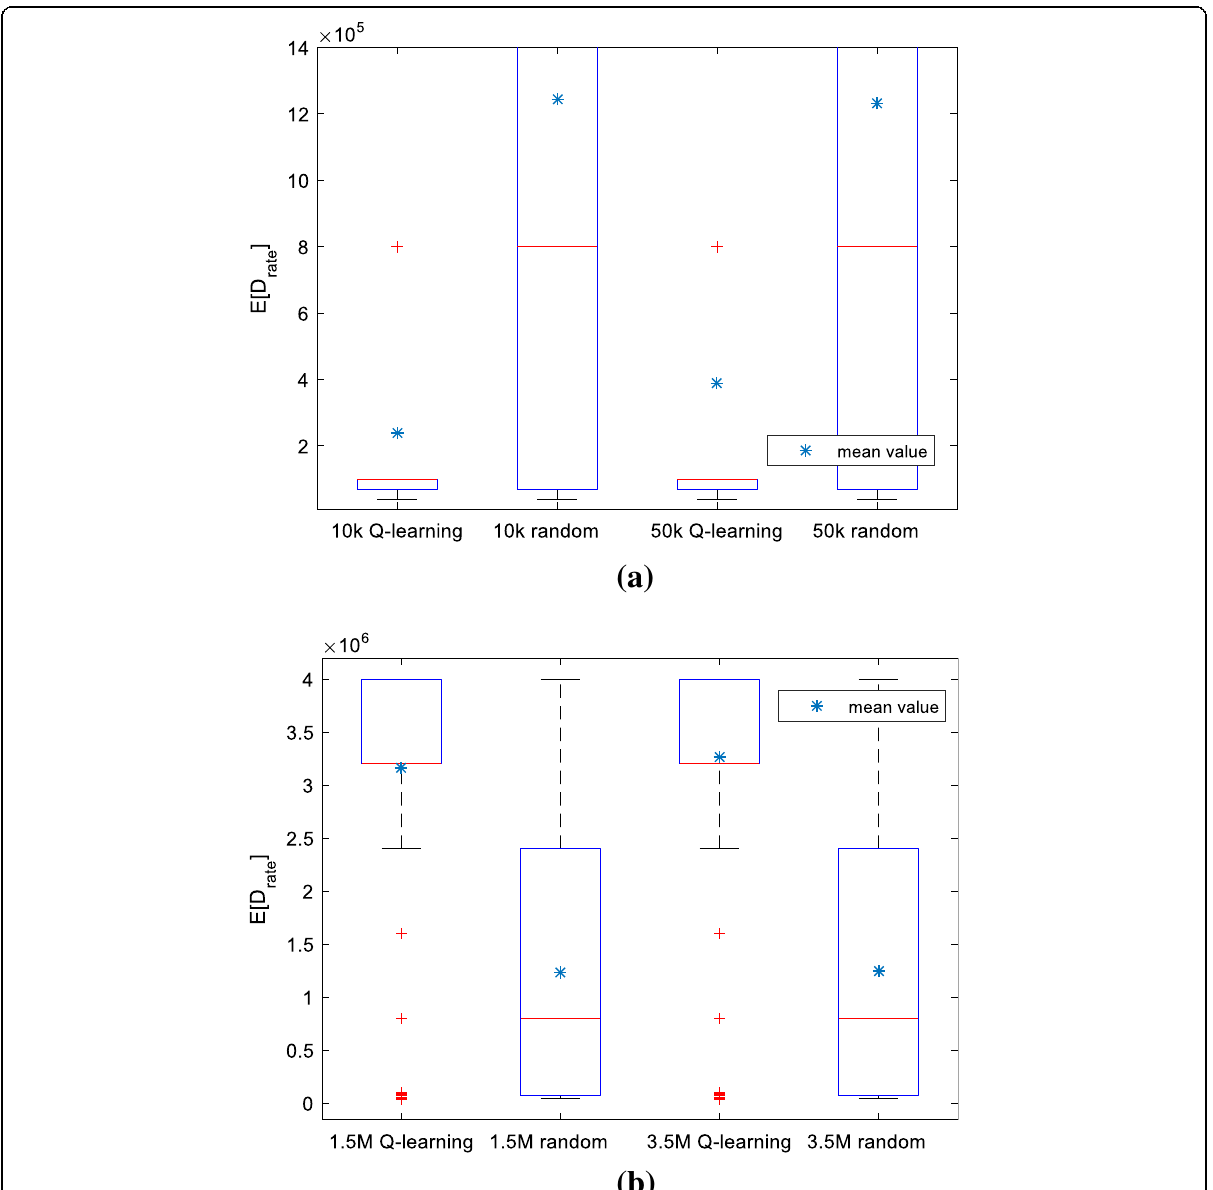
Fig. 19 a Mean value and b boxplot of data transmission rate for Q-learning and random channel selection. Shows the mean and boxplot of the data transmission rate for Q-learning and random channel selection for each DDR. In cases of the random channel selection, the average data transmission rate of all DDR cases is the same as the average value of the data rates for all channels in Table 1 belonging to band groups 1 and 2. The boxplots of all DDR cases for the random channel selection have a similar distribution. For the DDR of 10 kbps and 50 kbps, the mean of the Q-learning selection is lower than the random selection and the Q-learning has more narrow distribution. For the DDR of 1.5 and 3.5 Mbps, the mean of the Q-learning selection is higher than the random selection and the Q-learning has more narrow